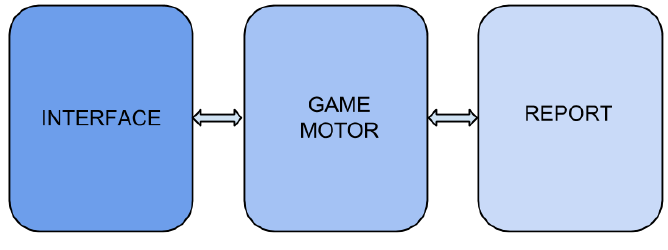
Figure 4. High-level design